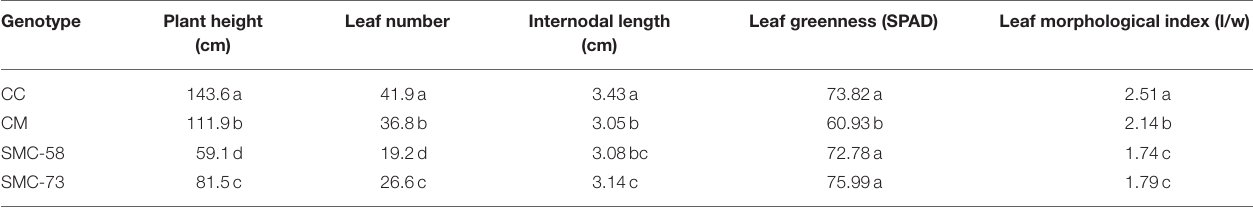
Values are the mean of 12 plants (n = 12). Different letters within each column indicate significant differences for P ≤ 0.05 on multiple range Duncan’s